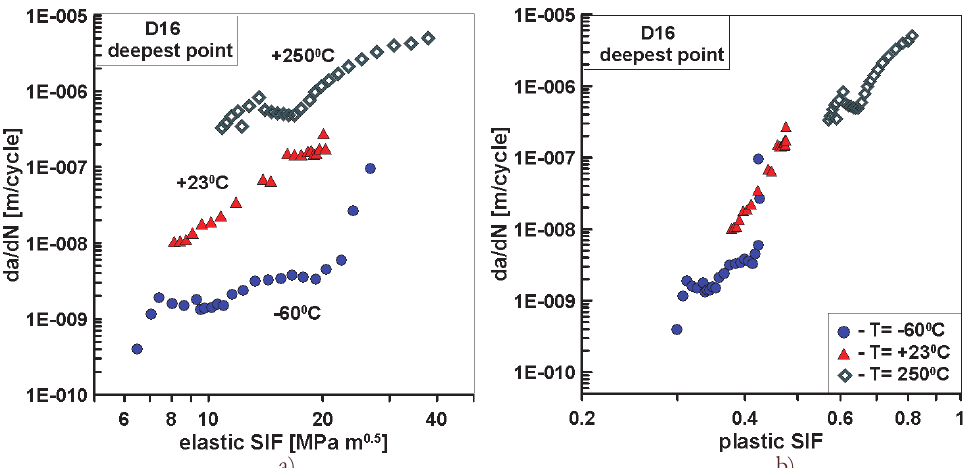
Figure 11: Crack growth rate as a function of (a) elastic and (b) plastic SIFs for deepest point of the crack front.